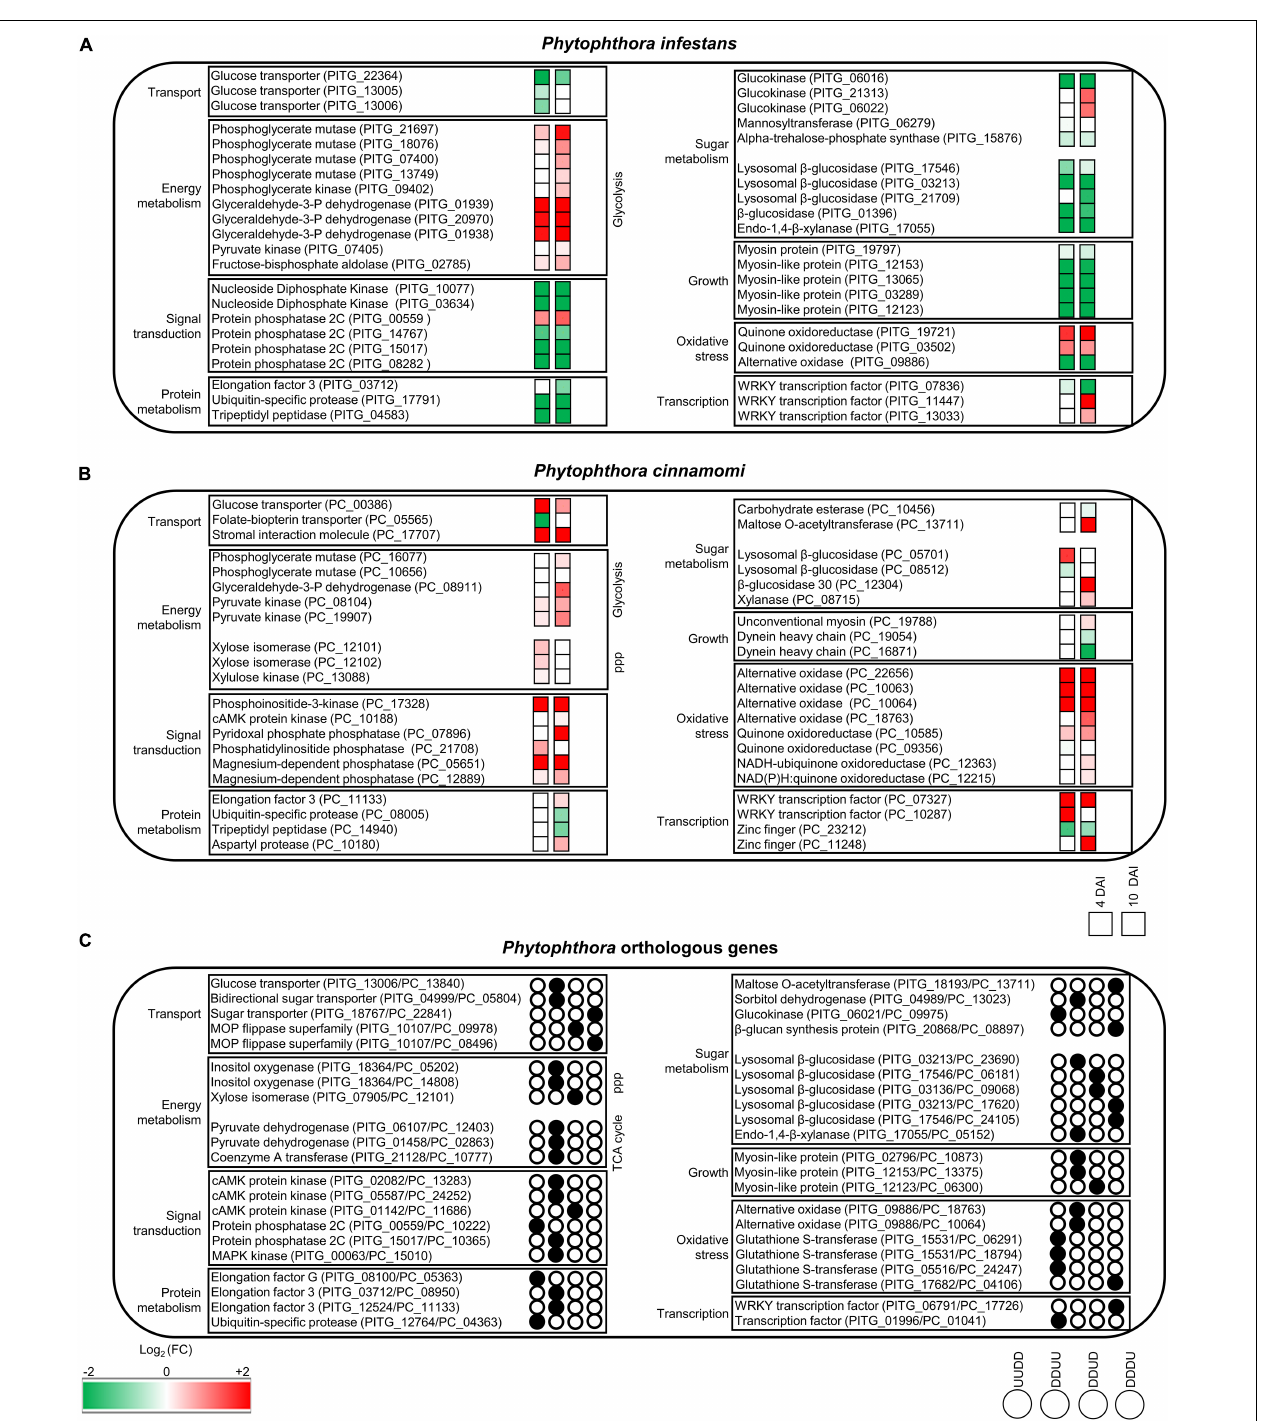
FIGURE 4 | Overview of the main processes modulated by tagatose in Phytophthor a spp. Main cellular pathways affected by tagatose were identified for differentially expressed genes (DEGs) of P. infestans (A) , P. cinnamomi (B) , and Phytophthora spp. orthologous (C) genes at 4 and 10 days after incubation (DAI) on pea agar medium. For each P. infestans and P. cinnamomi gene, two squares represent the Log 2 -transformed fold change values of tagatose-incubated samples calculated as compared to control samples at 4 (left square) and 10 (right square) DAI, according to the color scale reported. Orthologous DEGs were grouped in 16 clusters (defined by a four-letter code, black circles) based on their upregulation (U) or downregulation (D) in tagatose-incubated samples [ P. infestans at 4 DAI (first letter); P. infestans at 10 DAI (second letter); P. cinnamomi at 4 DAI (third letter); P. cinnamomi at 10 DAI (fourth letter)], such as genes upregulated in P. infestans and downregulated in P. cinnamomi at 4 DAI and at 10 DAI (UUDD), genes downregulated in P. infestans at 4 DAI and at 10 DAI and upregulated in P. cinnamomi at 4 DAI and at 10 DAI (DDUU), at 4 DAI (DDUD) or at 10 DAI (DDDU).